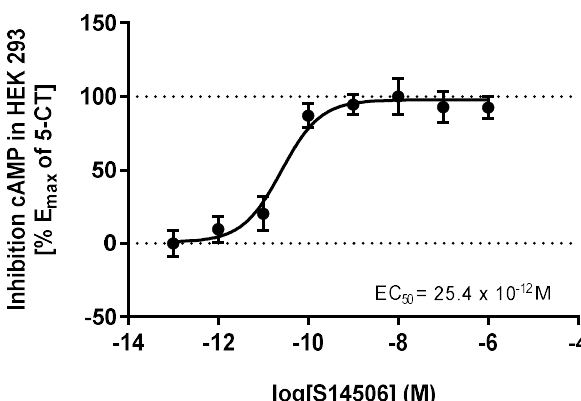
Figure 4. Induction of apoptosis (sum of early and late apoptosis) and necrosis in PC-3 prostate cancer cells after 72 h of incubation with fluoxetine ( A ) and compound AZ07 ( B ).